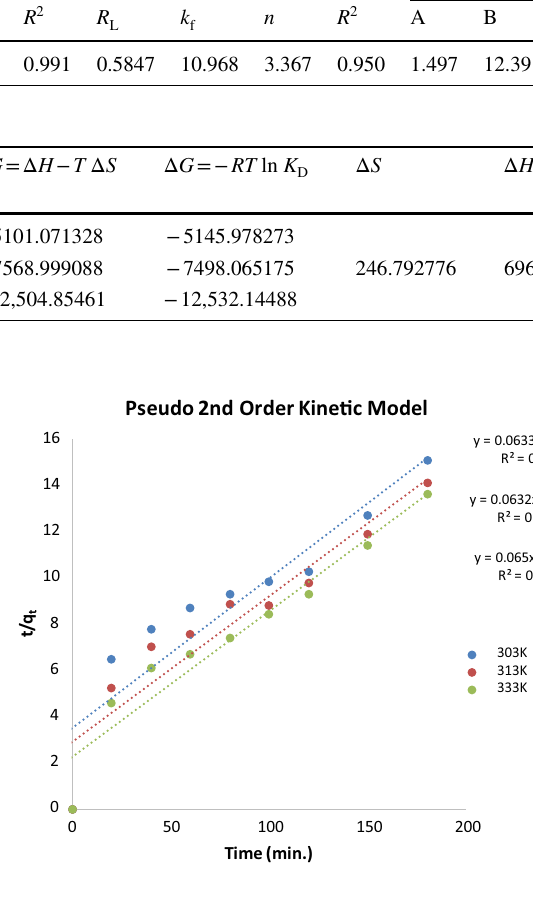
Fig. 18 Pseudo-second-order kinetic model. Temperature—30,